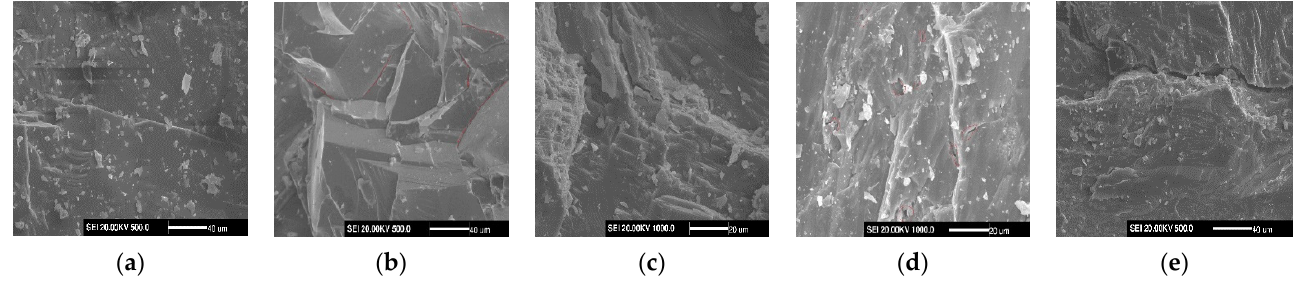
Figure 4. Scanning electron microscope characterization of samples: ( a ) 25 °C, ( b ) 100 °C, ( c ) 200 °C, ( d ) 300 °C, ( e ) 400 °C.